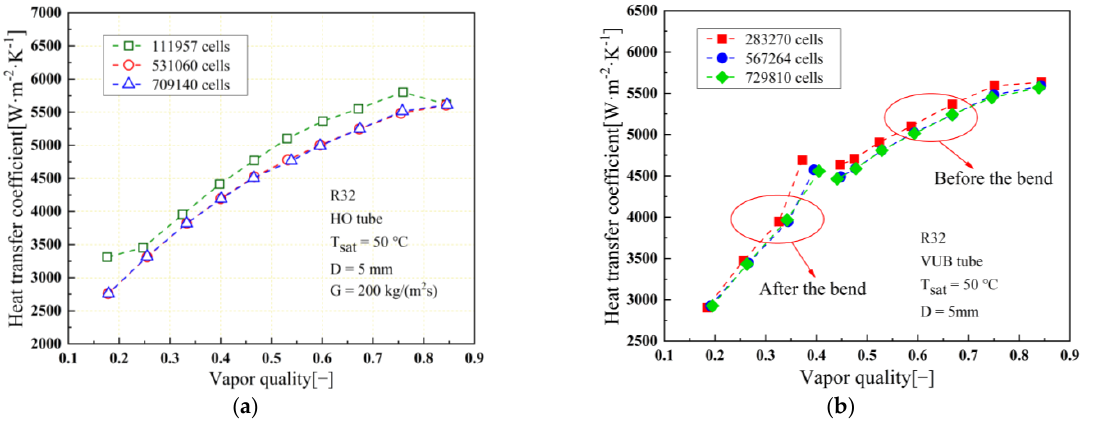
Figure 4. Simulated results of the heat transfer coefficient of R32 under different cells. ( a ) HO tube; ( b ) VUB tube. ( b ) VUB